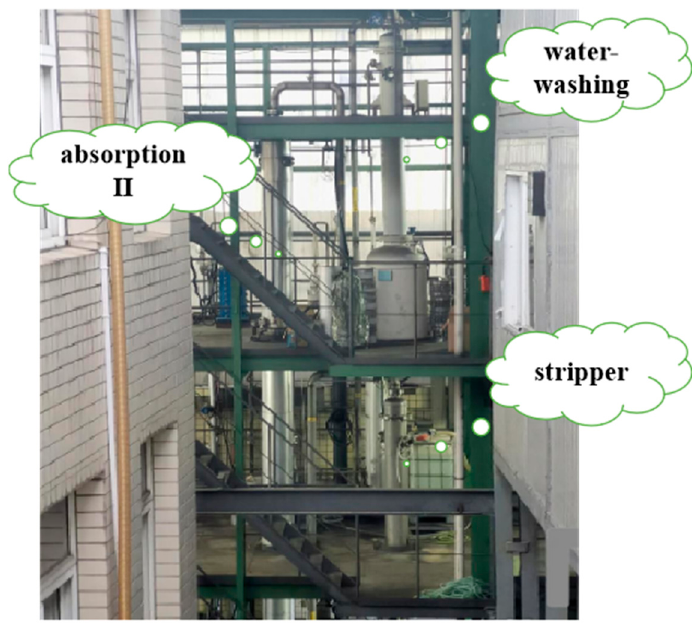
Figure 2. Elevation layout of the test platform.